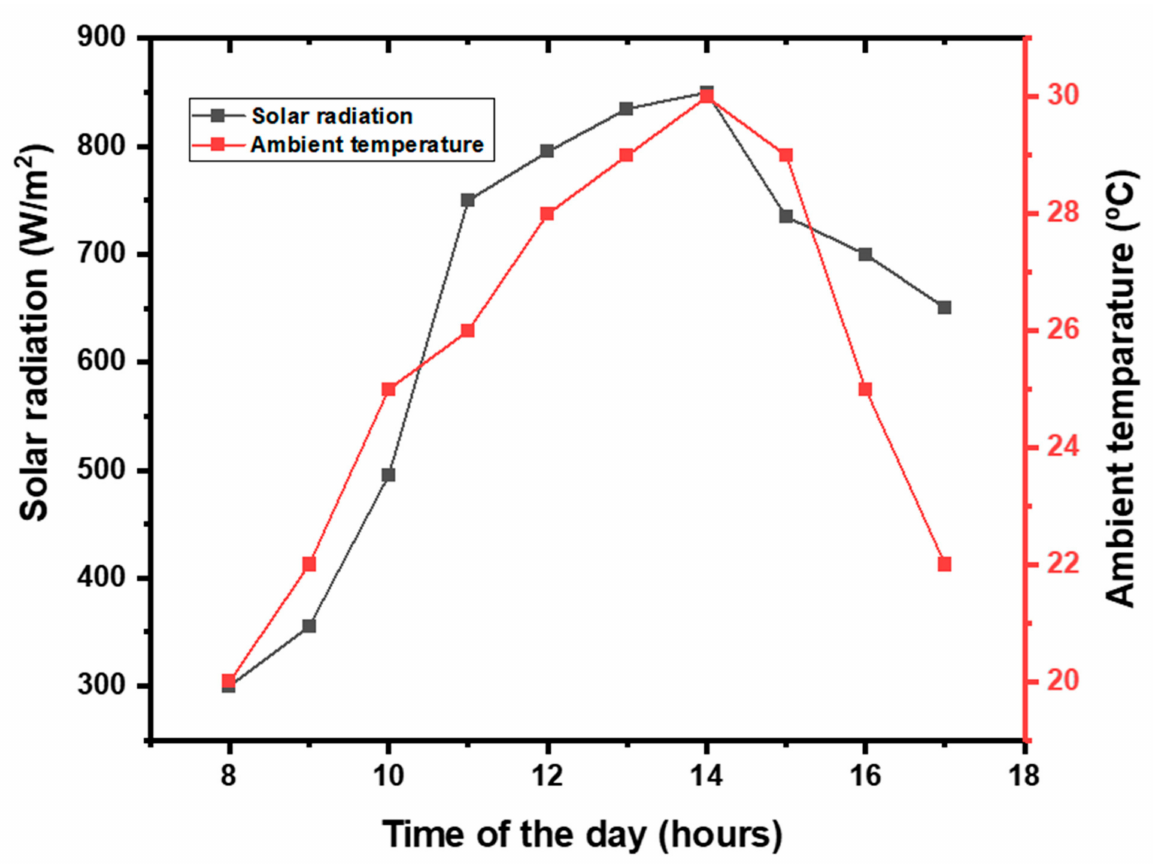
Figure 3. Hourly variation of atmospheric temperature and sun radiation at